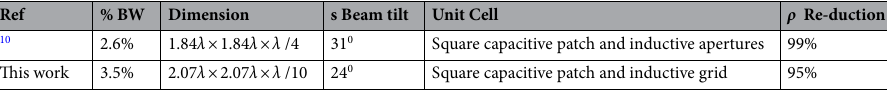
Table 2. Proposed designs of low-profile FP in literature for single source